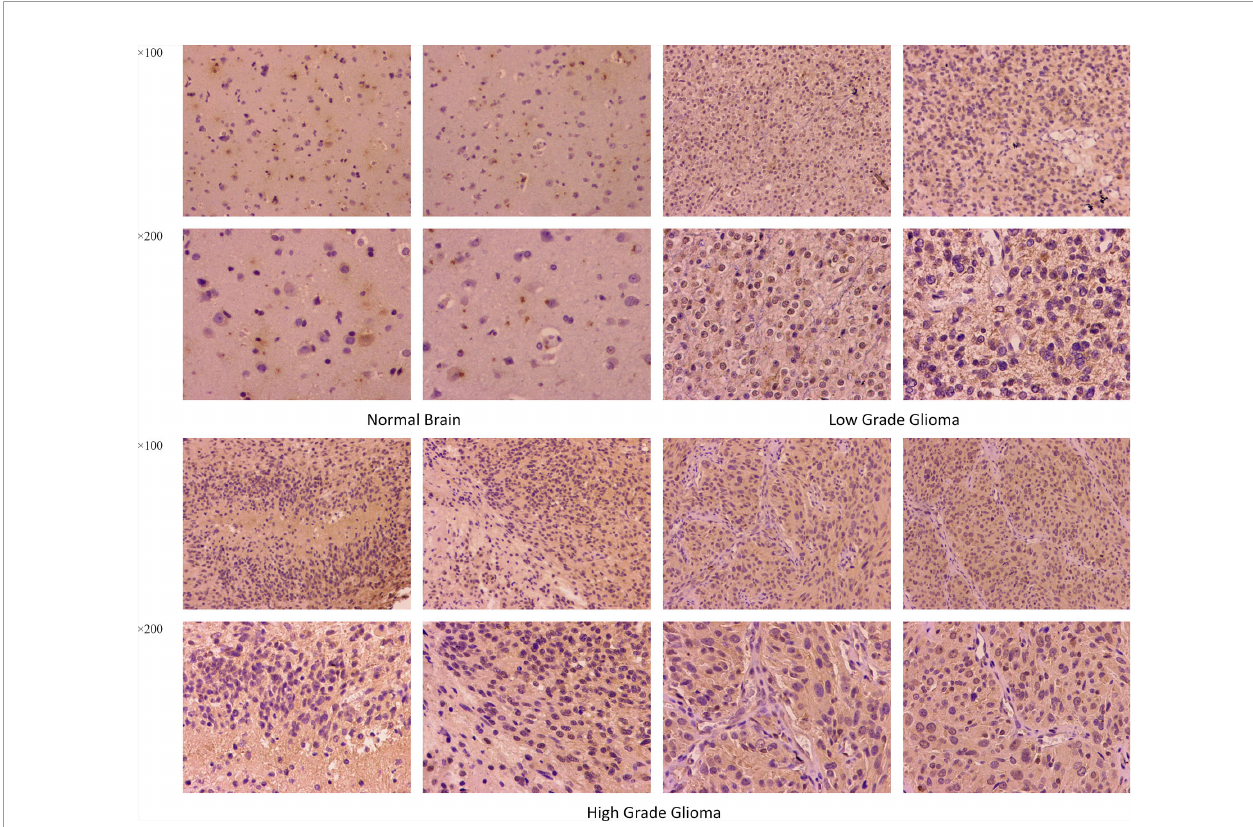
FIGURE 12 | Immumohistochemical staining for TNFRSF12A expression in normal brain, low-grade glioma and high-grade glioma tissues. Magni fi cation, ×100, ×200.